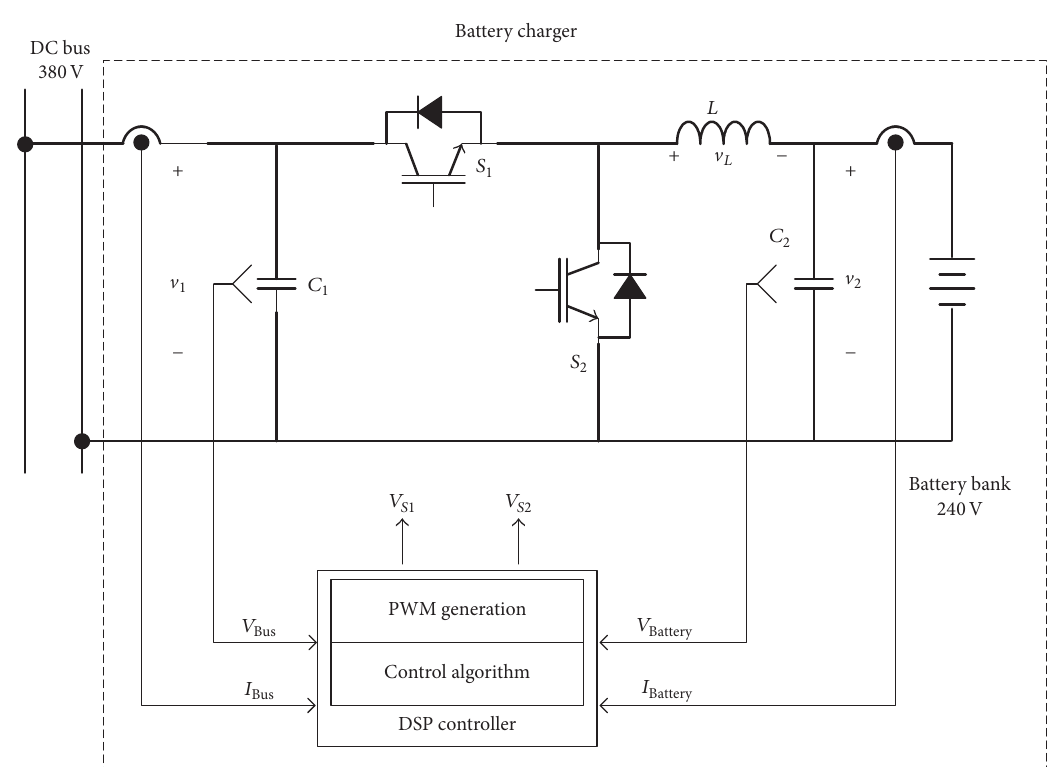
Figure 3: Battery charger system